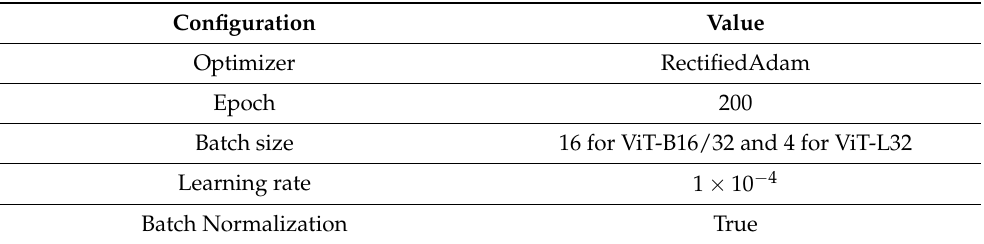
Table 1. Hyperparameter